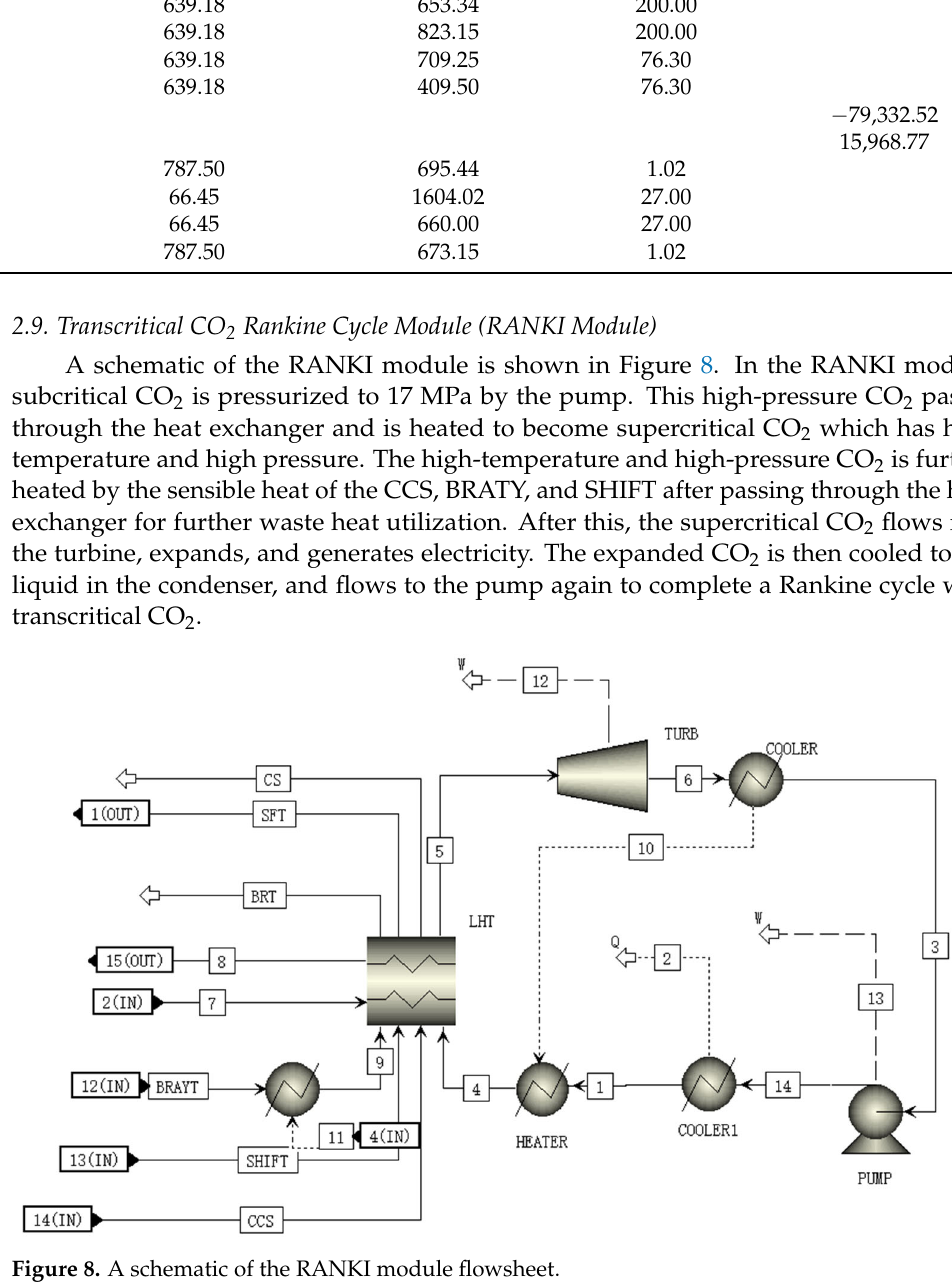
Table 10. Stream parameters in RANKI.